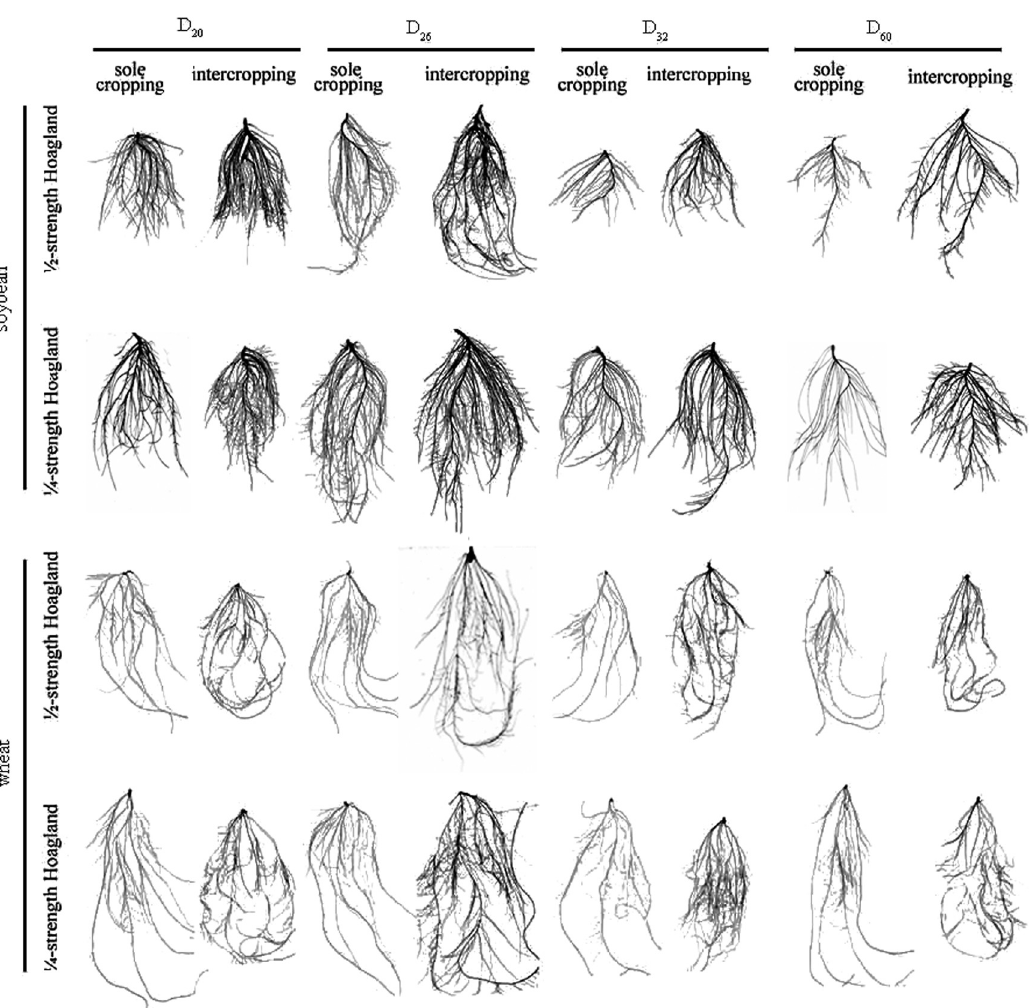
Fig 3. Root images for soybean/wheat sole cropping and intercropping populations under different nutrient levels and planting densities.